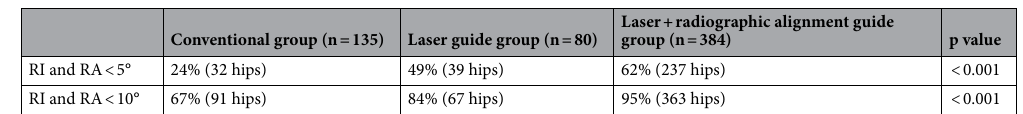
Table 3. Percentage of the error less than 5° and 10° in both RI and RA. RI radiographic inclination, RA radiographic